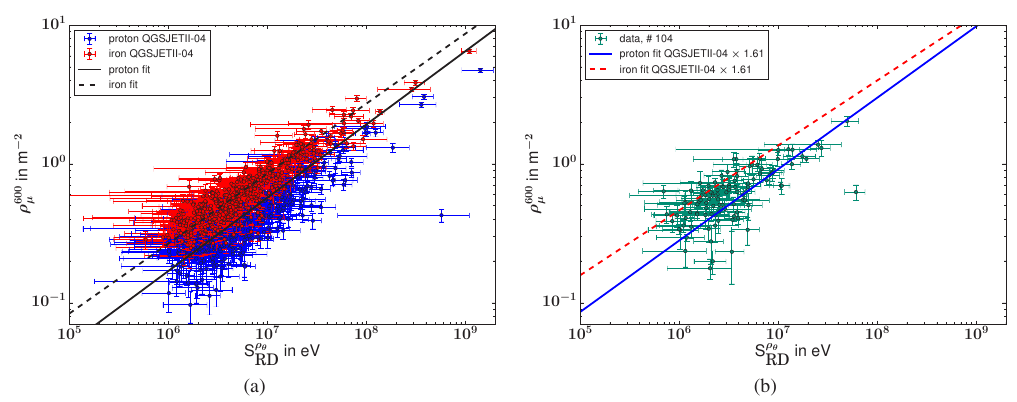
Figure 2 . Correlation of the muon density and the radiation energy for (a) simulations including detector Figure 1 . (a) Muon-radio mass estimator versus zenith angle for showers with a primary energy of 1 responses of AMIGA and AERA and measured radio background, and (b) coincident measurements of EeV. The lines show the mean values µ i and the shaded areas depict the standard deviations σ i . (b) AMIGA and Mass separation power of di ff erent mass estimators, represented by the figure of merit (FOM). The indices signify proton (P) and iron nuclei (Fe). No uncertainties from detector e ff ects are included.